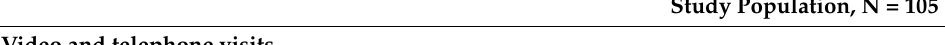
Study Population, N = 105